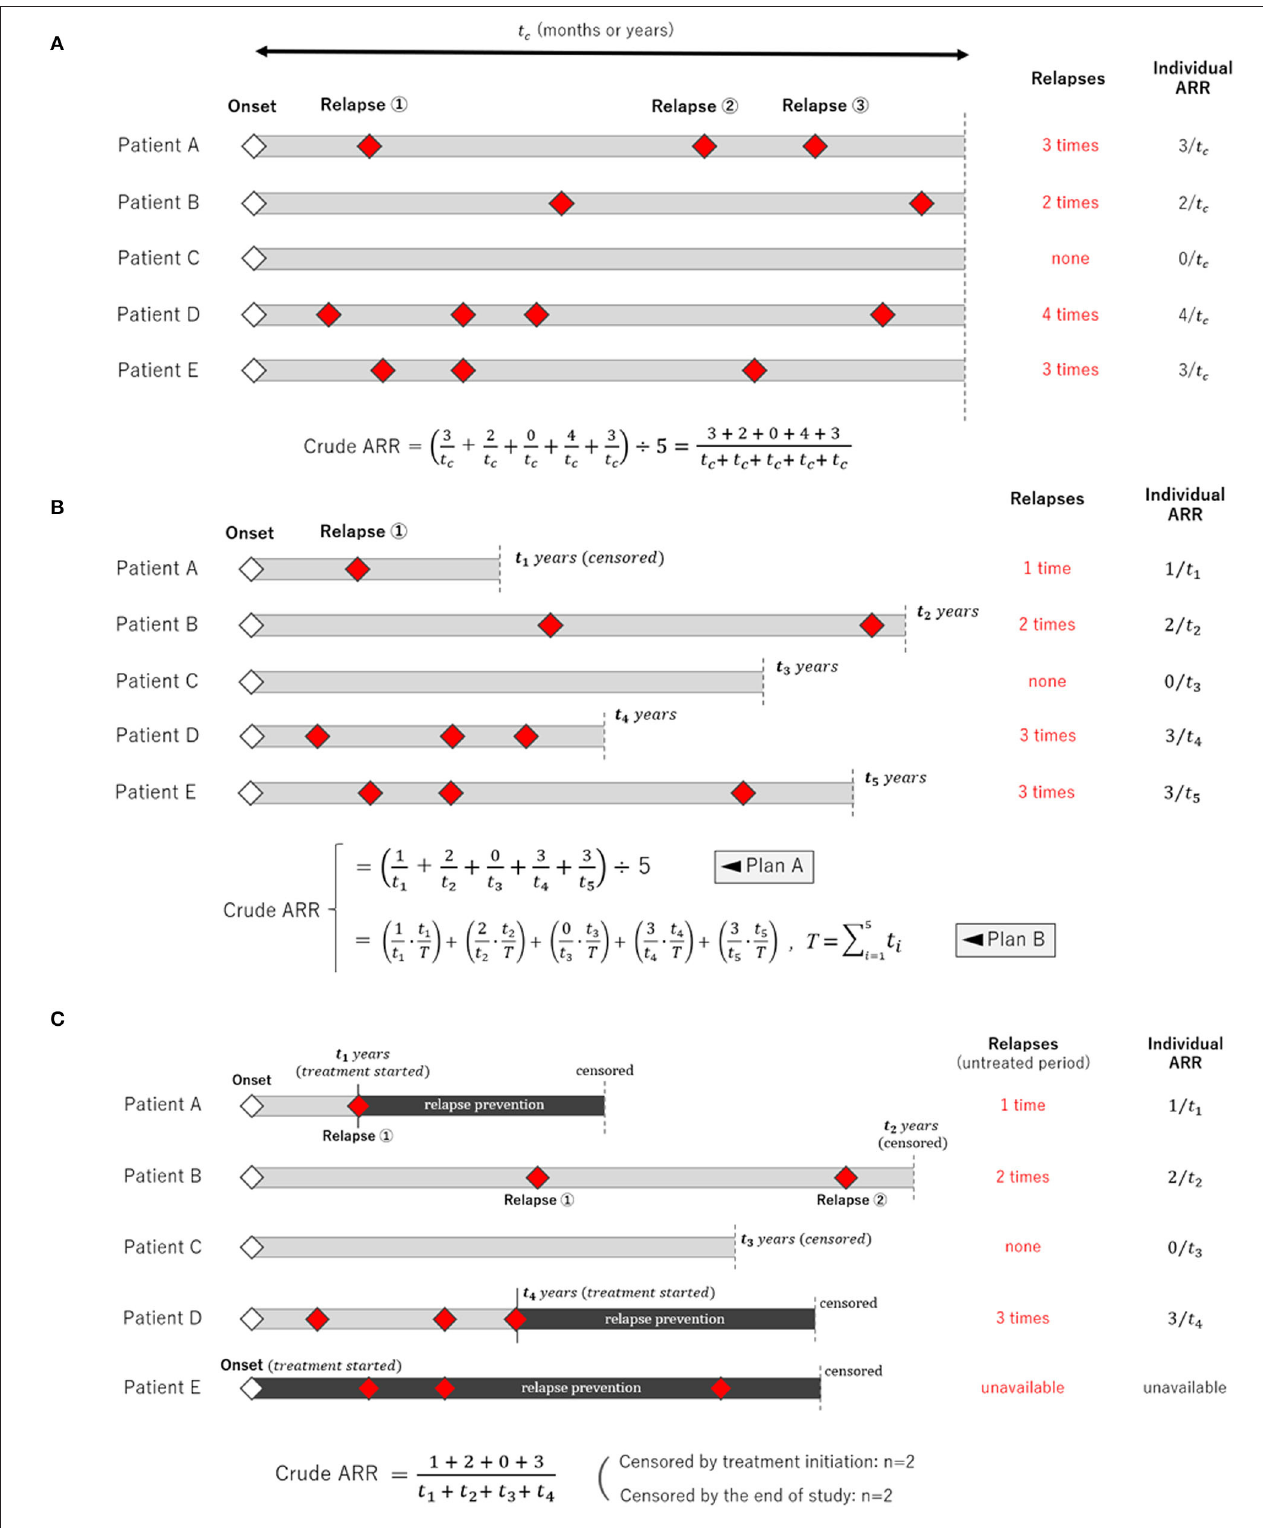
FIGURE 2 | Schemes of clinical studies with different types of the follow-up period. Three different scenarios of clinical observational studies with different follow-up periods for each participant are shown. (A) The follow-up period was fixed and equal among the study participants. (B) The follow-up period varied among the participants, in which case averaging only the individual relapse rate (Plan A) is insufficient, and applying the person-years method (Plan B) is more appropriate. This is because the person-years method can weigh different follow-up periods in each participant. (C) The follow-up period in many participants is censored by the occurrence of an event, and each participant’s follow-up period could be influenced by the occurrence of an event.